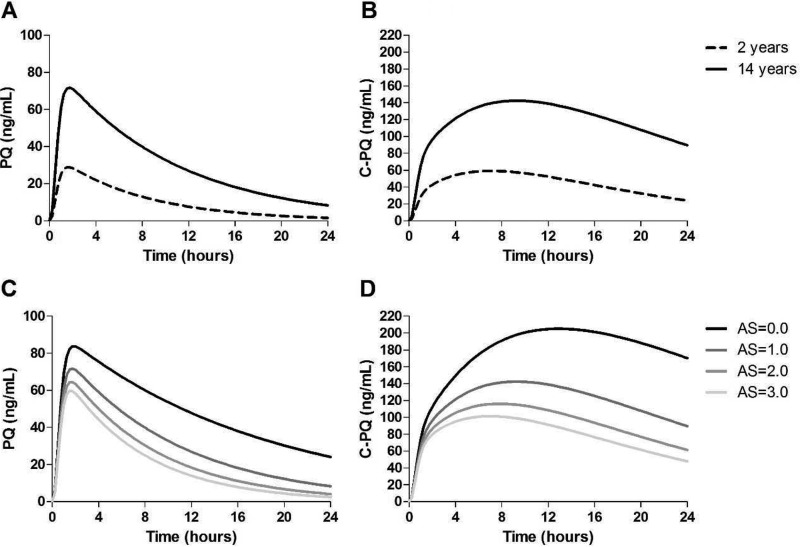
Effect of age and CYP2D6 activity score (AS) on PQ and C-PQ plasma concentrations over time after a 0.25-mg/kg single dose of PQ. Panels A and B, respectively, show the effects of age on PQ and C-PQ concentrations over time in two hypothetical children of different ages (2-year-old, 12-kg body weight; 14-year-old, 40-kg body weight), with a CYP2D6 AS = 1.0. Panels C and D, respectively, show the effects of genetically determined CYP2D6 AS in four hypothetical 14-year-old children on the PQ and C-PQ concentration over time. The values used to construct curves are model derived.